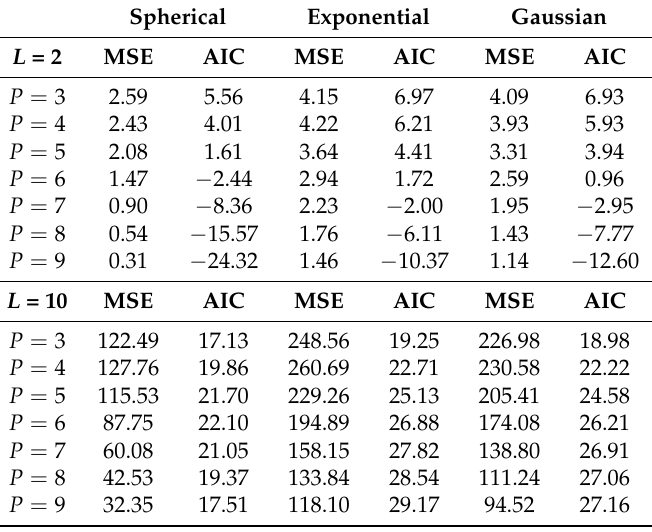
Table 1. Semivariogram modeling (mean square error (MSE) and Akaike information criterion (AIC)) in the symmetric case for L = 2 and L = 10. Minimums are highlighted in violet